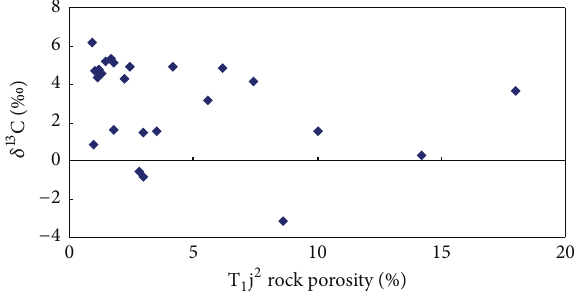
Figure 11: Relationship between carbon isotope and porosity.